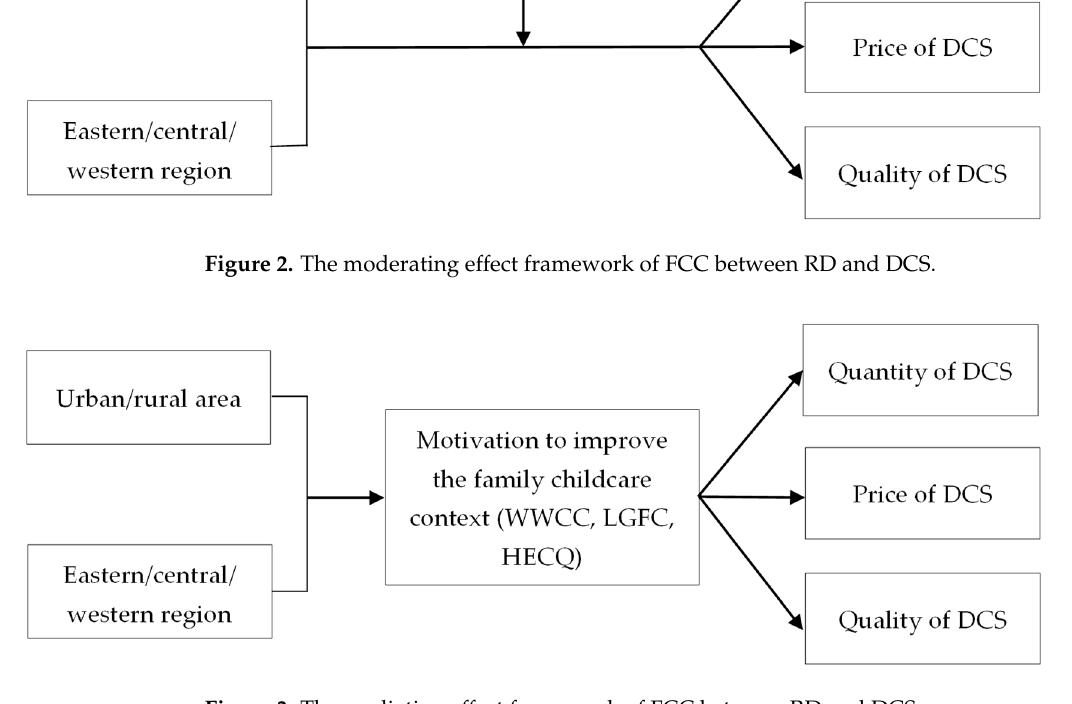
Figure 3. The mediating effect framework of FCC between RD and DCS.